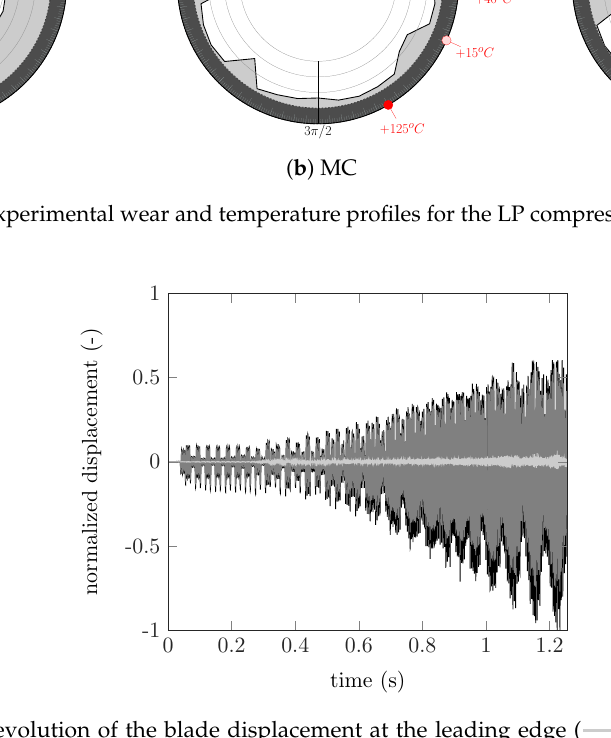
Figure 16. Time evolution of the blade displacement at the leading edge ( ), mid-chord ( ), and trailing edge ( ) for the LP compressor test